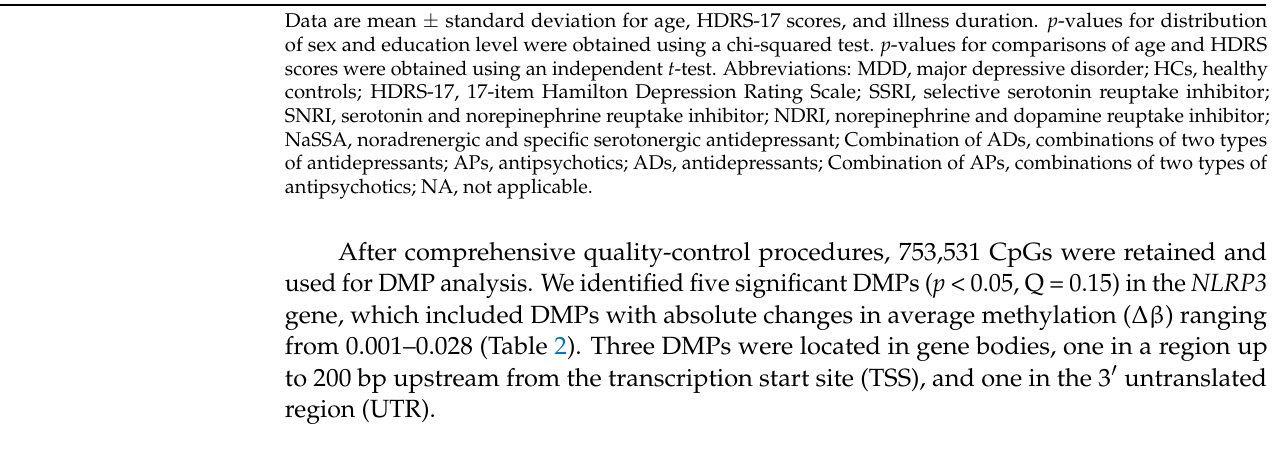
Table 2. Differentially methylated positions from methylation analysis in the total sample (P uncorr <